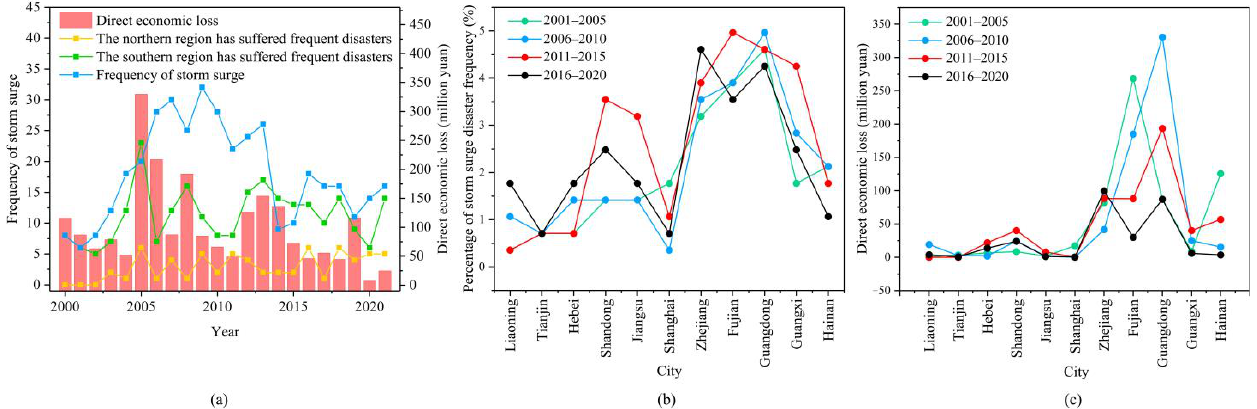
Figure 10. ( a ) Frequency of occurrence of storm surge disasters in China’s coastal areas, disaster frequency in southern and northern regions (dot plot), and direct economic losses from storm surge disasters (bar chart) from 2000 to 2021. ( b ) Storm surge disaster frequency as a percentage of total disaster frequency in coastal areas of China from 2001 to 2020. ( c ) Direct economic losses from storm surge disasters in coastal areas of China from 2001 to 2020.